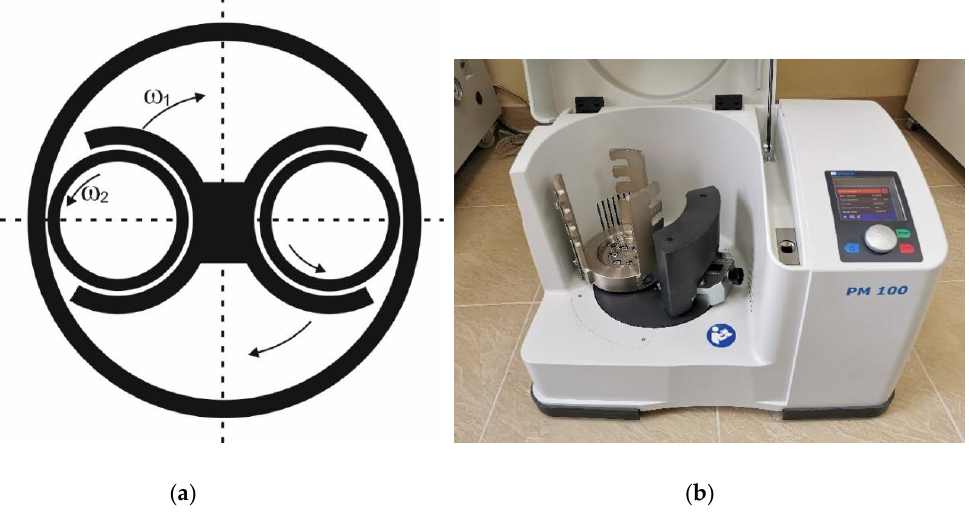
Figure 4. A planetary mill: ( a ) the flow diagram of a planetary mill; ( b ) photograph of the real-world